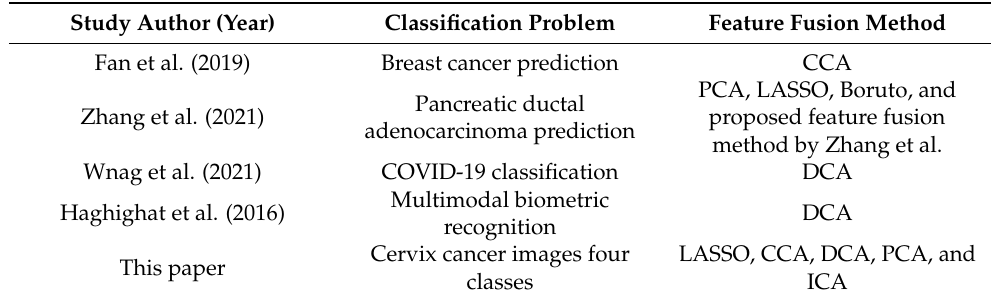
Table 4. Most recent studies show the effectiveness of data feature fusion in improving classification accuracy on other medical diagnostic problems. Most of the mentioned feature fusion methods were selected as a part of our comparative